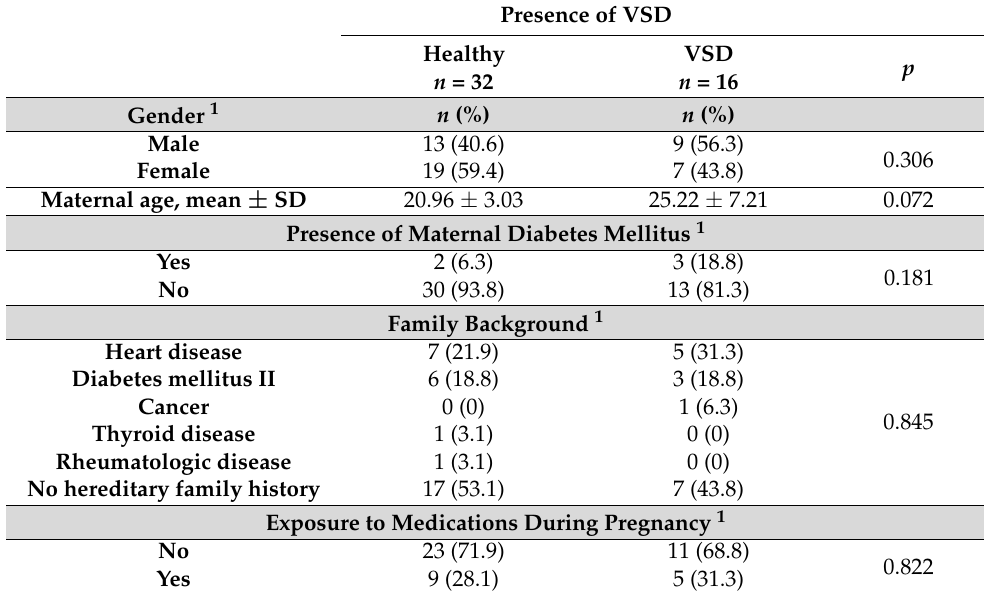
Table 1. Contrast of clinical variables and maternal folic acid intake in